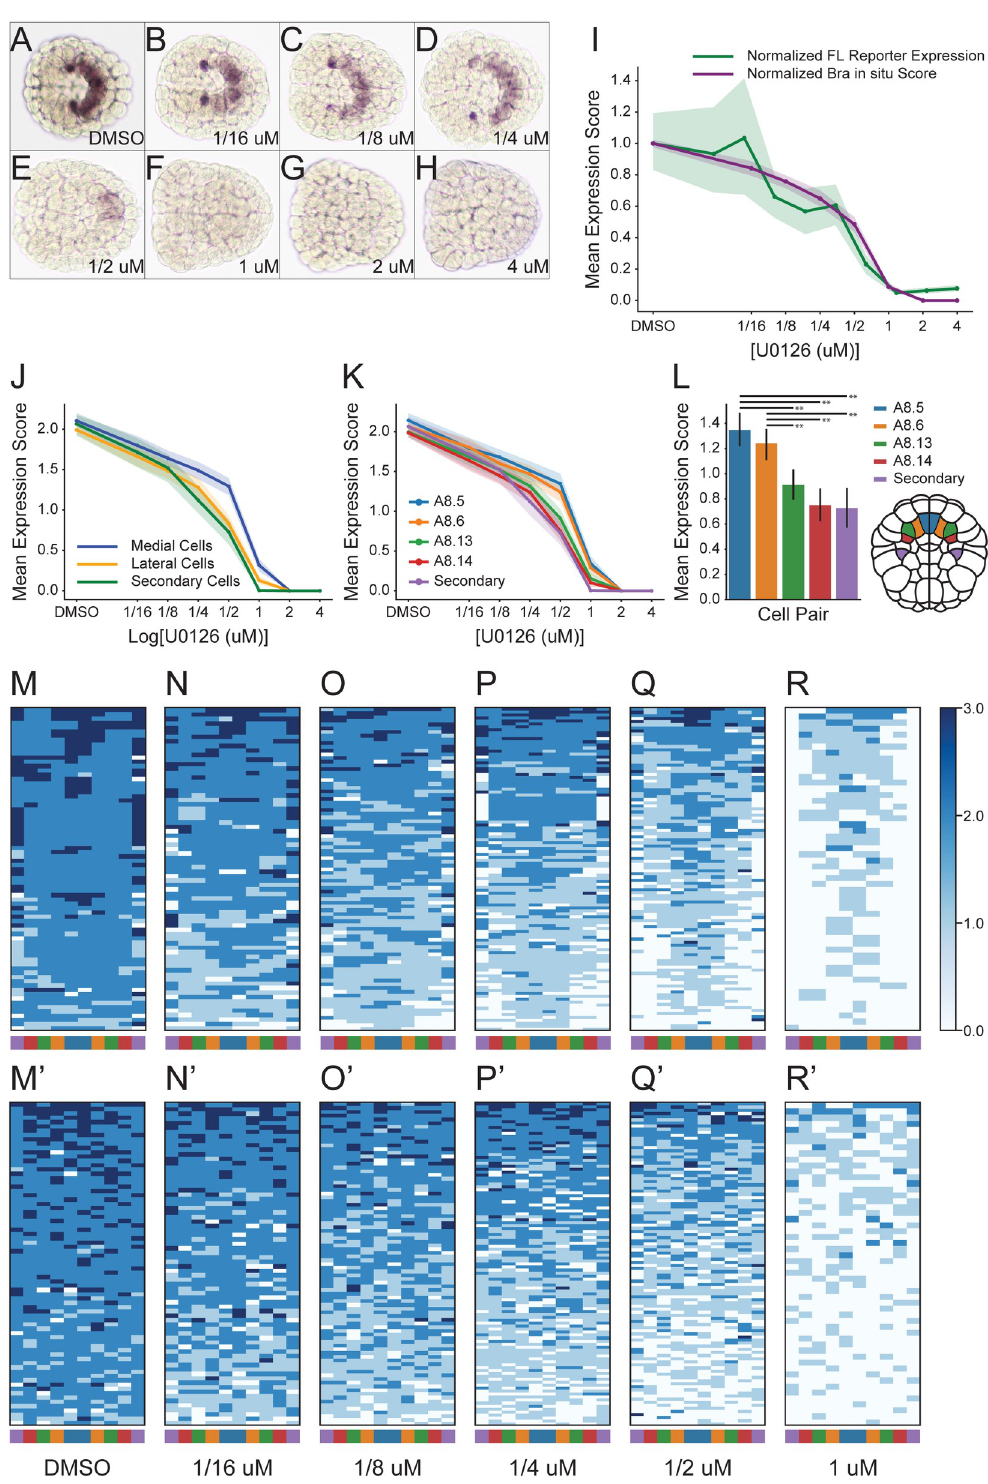
Fig 4. Endogenous Bra expression in response to graded MAPK inhibition. (A-H) Representative images of mid-gastrula stage embryos at the indicated doses stained by in situ hybridization for endogenous Bra expression. (I) U0126 dose- response curves for semiquantitative scores of endogenous Bra expression (purple) overlaid on the Full Length reporter whole-embryo expression data (green). Both dose-response curves are scaled to 1 at the DMSO control dose.